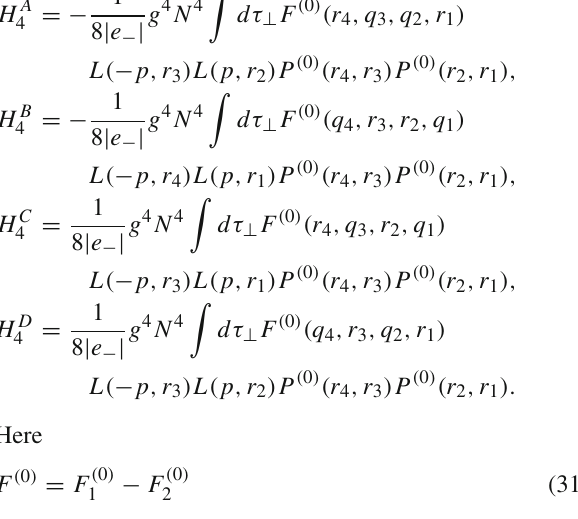
Fig. 7 The diffractive amplitudes with four reggeons attached to the projectile